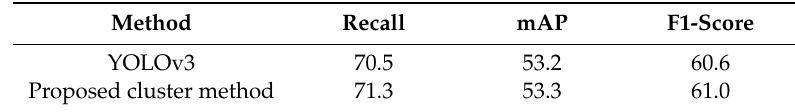
Table 3. Comparison between YOLOv3 and proposed cluster method on the MS COCO dataset: Recall (%), mAP (%) and F1-score